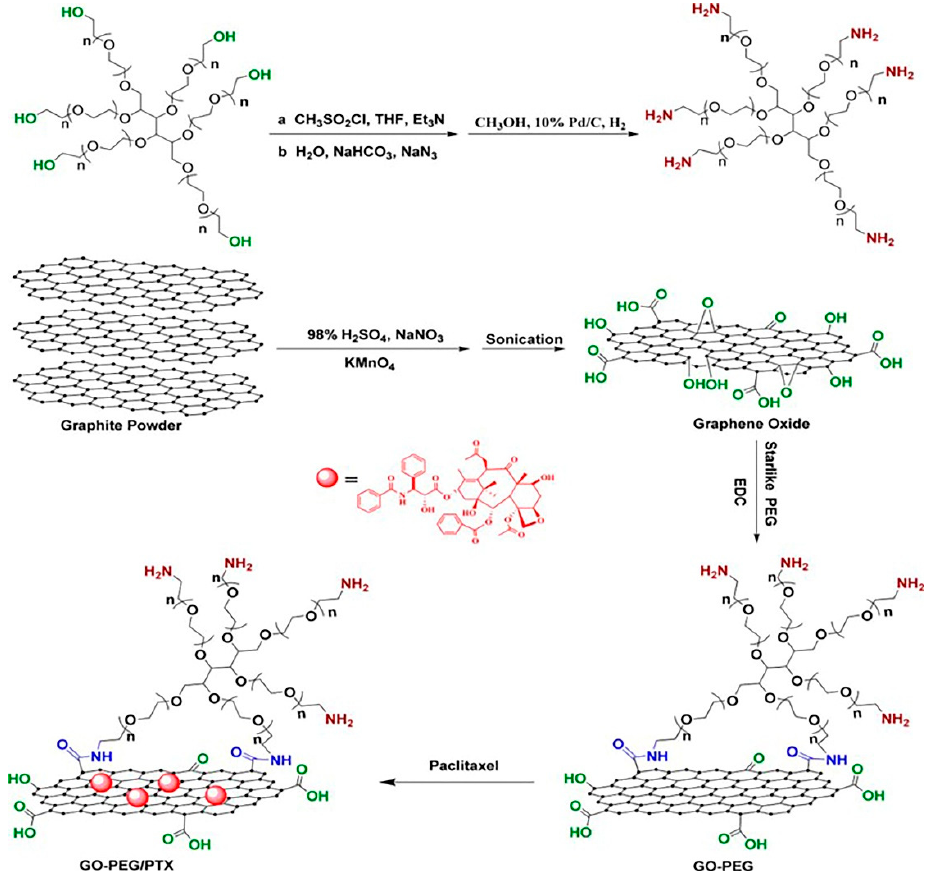
Figure 7. Preparation of graphene oxide (GO)–polyethylene glycol (PEG)/paclitaxel (PTX) nanoscale drug delivery system [140]. (Reprinted with permission from Zhiyuan Xu et al. ‘Covalent Functionalization of Graphene Oxide with Biocompatible Poly(ethylene glycol) for Delivery of Paclitaxel’. ACS Appl. Mater. Interfaces 2014 , 6 , 17268 − 17276. Copyright (2020) American Chemical Society).